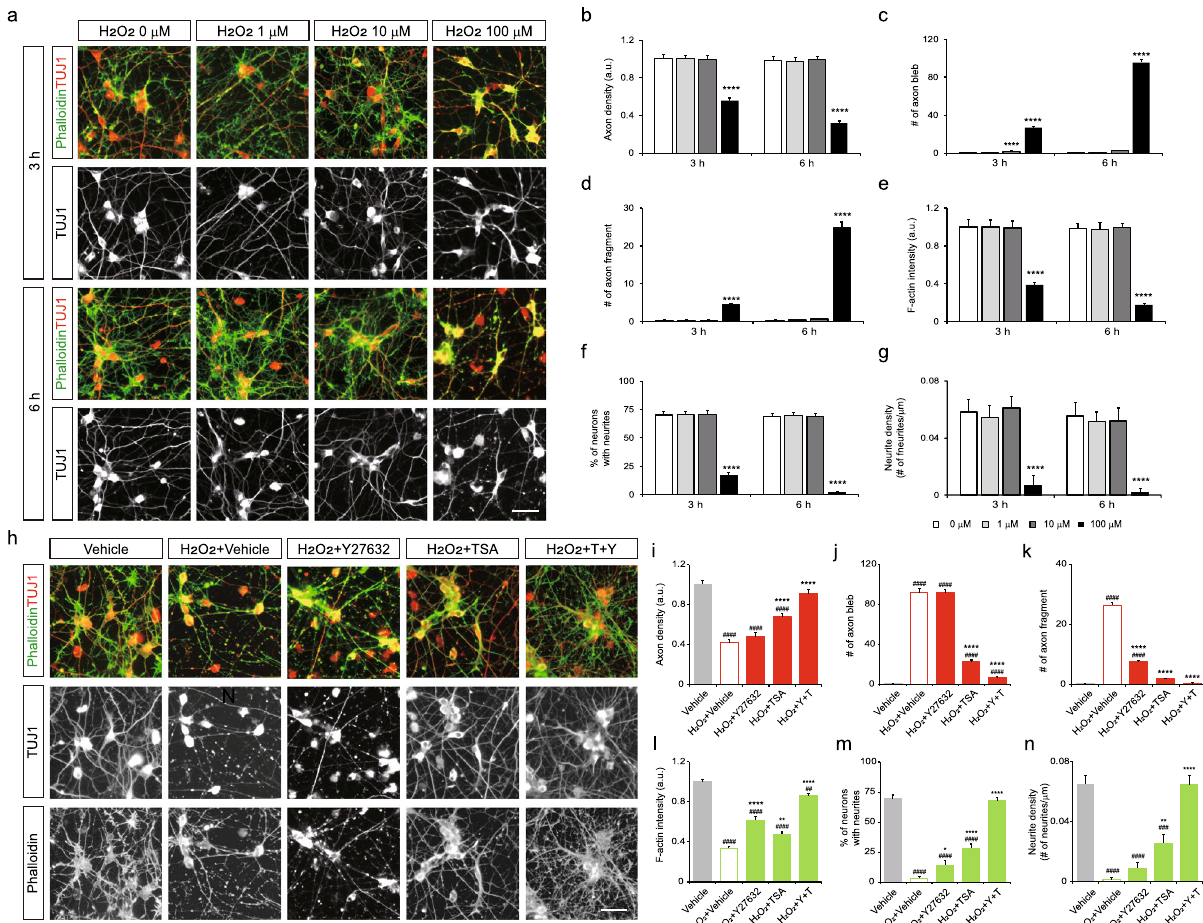
Figure 2. Oxidative stress-driven motor neuronal death and axon degeneration. ( a ) Images of dissociated motor neurons exposed to 1–100 μM of H 2 O 2 for 3 and 6 h, stained with phalloidin and immunostained with TUJ1 antibody. ( b – g ) Measurement of axon density, the number of axonal blebs and fragments, F-actin fluorescence intensity, % of neurons with neurites, neurite density per field (n = 24–36 images per condition). Error bars represent s.e.m.; ****p < 0.0001 versus 0 μM at 3 h or 6 h; one-way ANOVA test with Tukey’s test. ( h ) Images of motor neurons treated with 100 μM of H 2 O 2 and drugs for 6 h. ( i – n ) Quantification of axon density, the number of axonal blebs and fragments, F-actin fluorescence intensity, % of neurons with neurites, neurite density per field (n = 27 images per condition). Error bars represent s.e.m.; ## p < 0.01, ### p < 0.001, #### p < 0.0001 versus Vehicle; *p < 0.05, **p < 0.01, ****p < 0.0001 versus H 2 O 2 + Vehicle, one-way ANOVA test with Tukey’s test. Scale bars 10